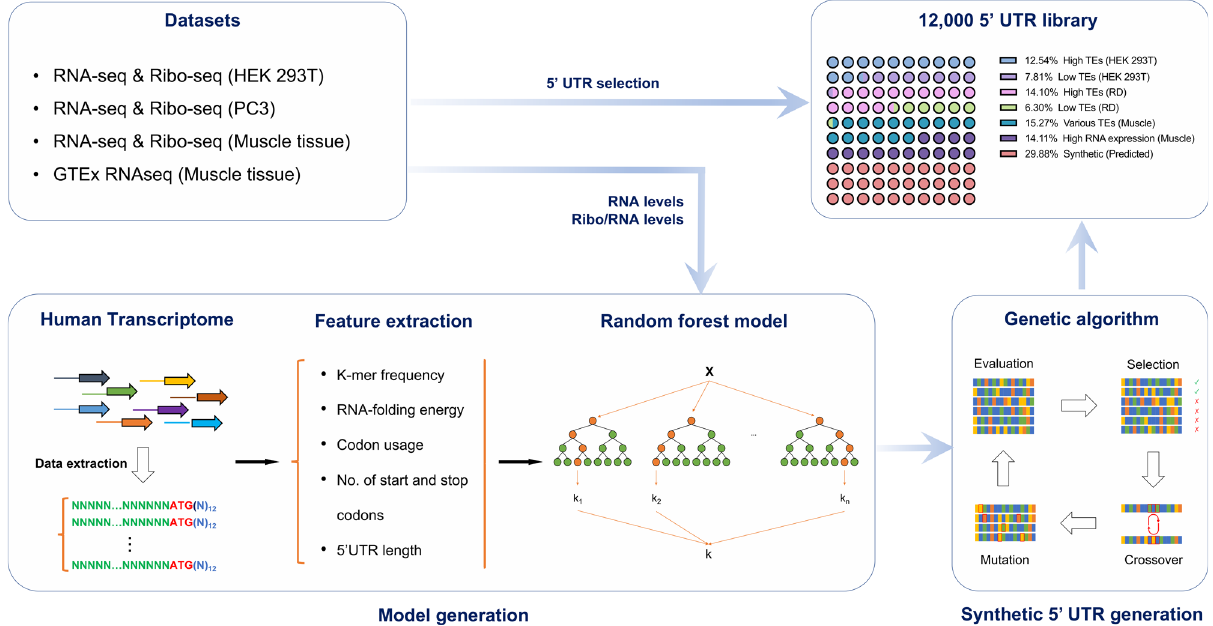
Fig. 2 Design of the 5 ′ UTR library of naturally occurring and synthetic 5 ′ UTRs. RNA-seq and Ribo-seq datasets of HEK 293T, PC3, and human muscle cells, together with the GTEx database of human muscle tissue, were collected. Natural 5 ′ UTRs with high TEs and low TEs in HEK 293T and RD cells, 5 ′ UTRs with various TEs in human muscle cells, and the 5 ′ UTRs with high mRNA counts in human muscle tissues were selected and added to the library. In addition, we designed synthetic 5 ′ UTRs by: (i) collecting endogenous 5 ′ UTR sequences on the target cell type (HEK 293T, PC3 or human muscle cells) from public data; (ii) extracting sequence features of the 5 ′ UTRs, including those nucleotides surrounding the AUG region; (iii) training a Random Forest machine learning method for each cell type/tissue (HEK 293T, PC3 or human muscle cells), to learn a function that maps sequence features to mRNA expression levels and TEs; and (iv) designing a set of 100 bp synthetic sequences that are predicted to maximize TEs and protein expression levels using genetic